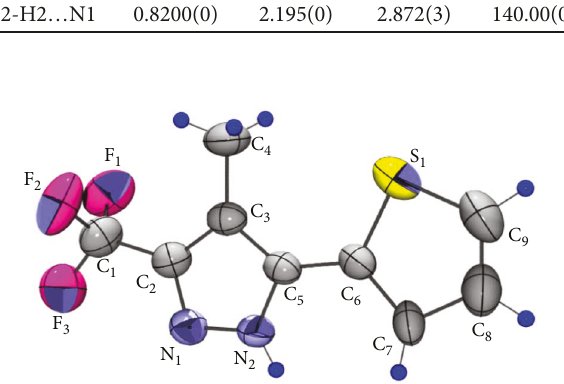
Figure 5: ORTEP view of the 5(3)-tri fl uoromethyl-4-methyl-3(5)- thien-2-yl-1 H -pyrazole (5) with the corresponding atom numbers. Displacement ellipsoids are drawn at the 50% probability level with hydrogen atoms represented by small spheres of arbitrary radii.